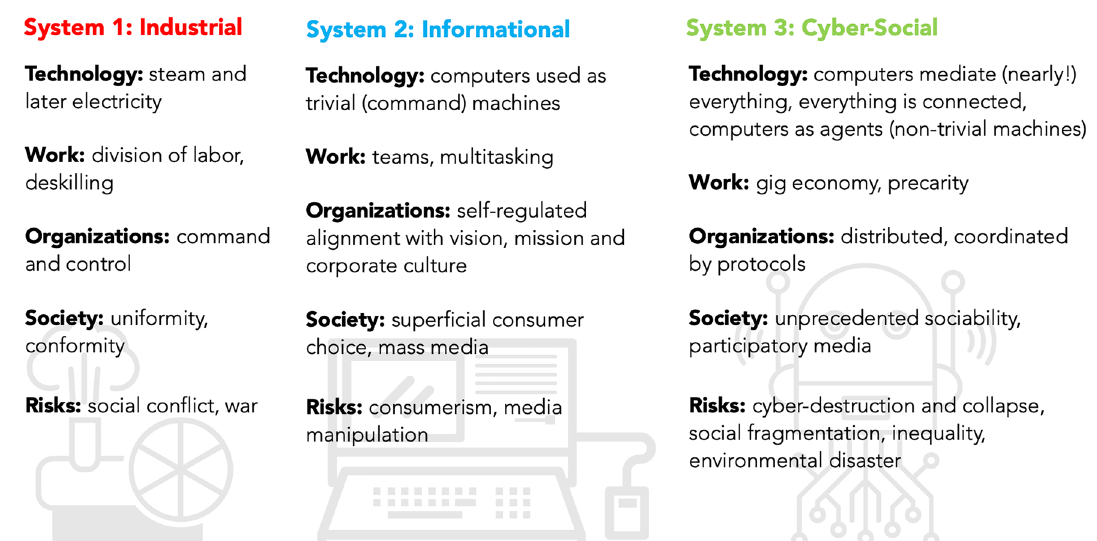
Fig. 8 From industrial, to informational, to cyber-social